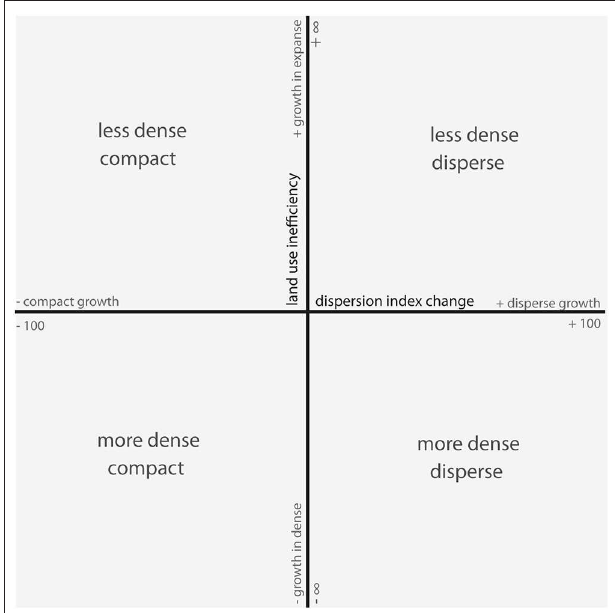
FIGURE 3 | Trends of urbanization, divided into the four quadrants.